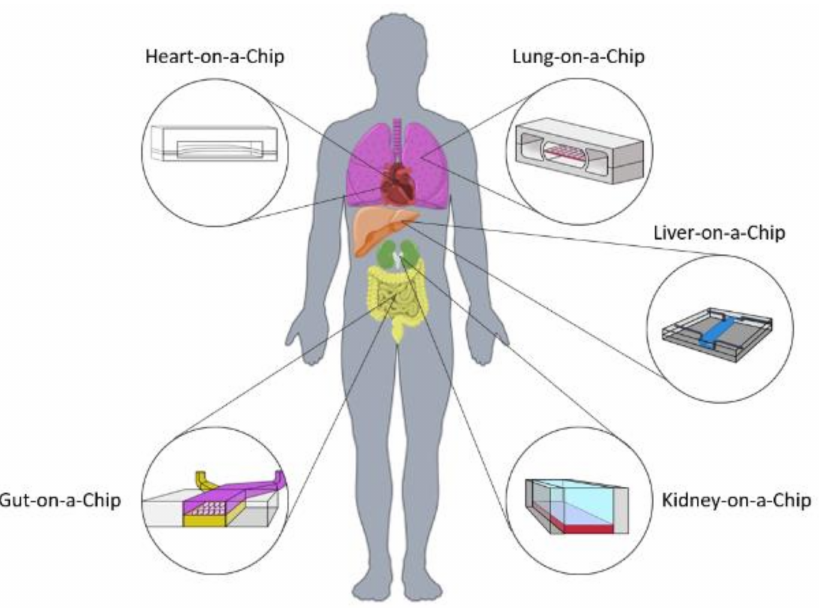
Figure 1. Human-on-a-Chip Scheme